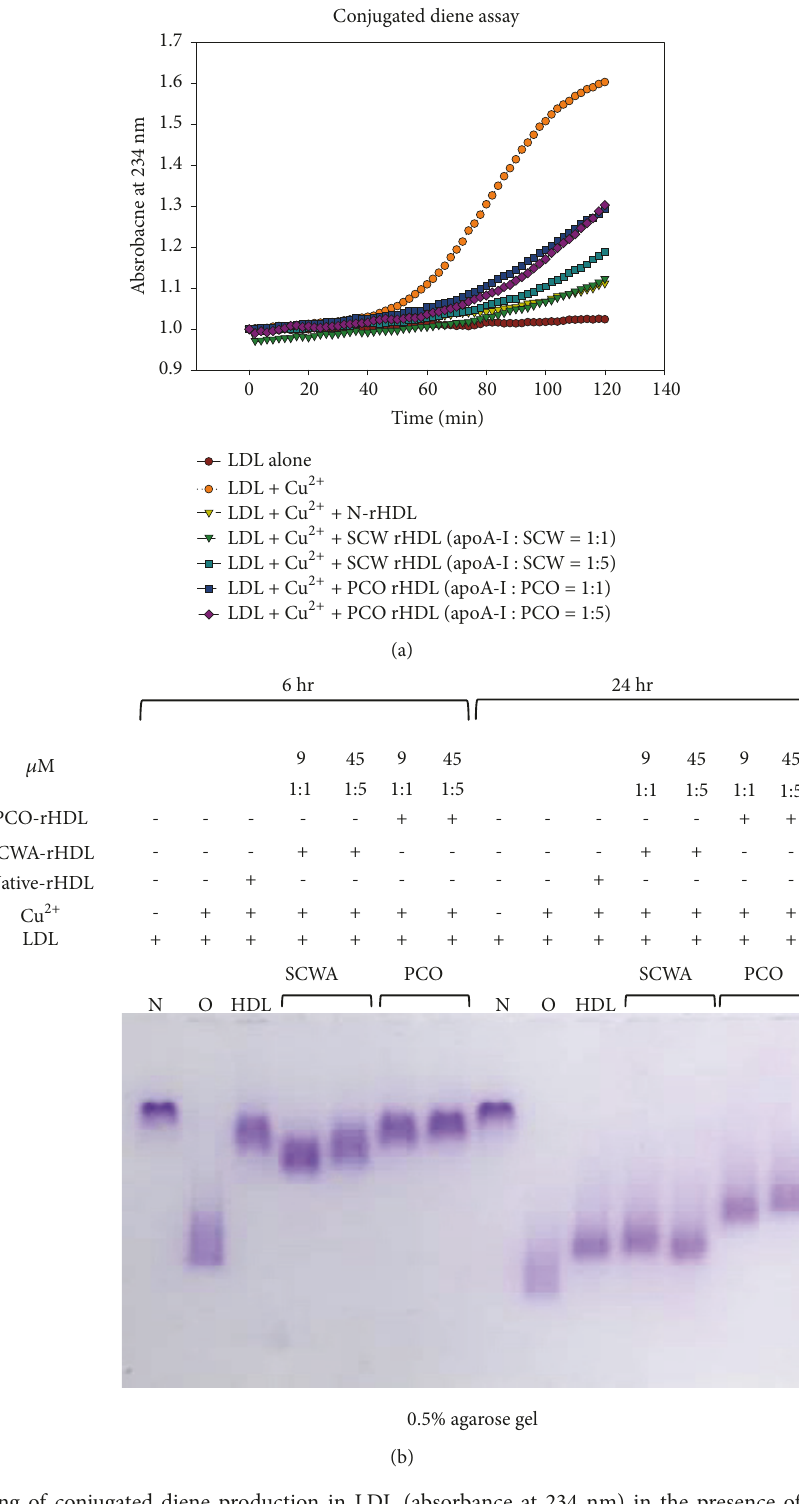
Figure 2: (a) Monitoring of conjugated diene production in LDL (absorbance at 234 nm) in the presence of rHDL containing either policosanol (PCO-rHDL) or SCWA (SCWA-rHDL). (b) Comparison of electromobility of LDL under presence of cupric ion and each rHDL for 6 hr and 24 hr